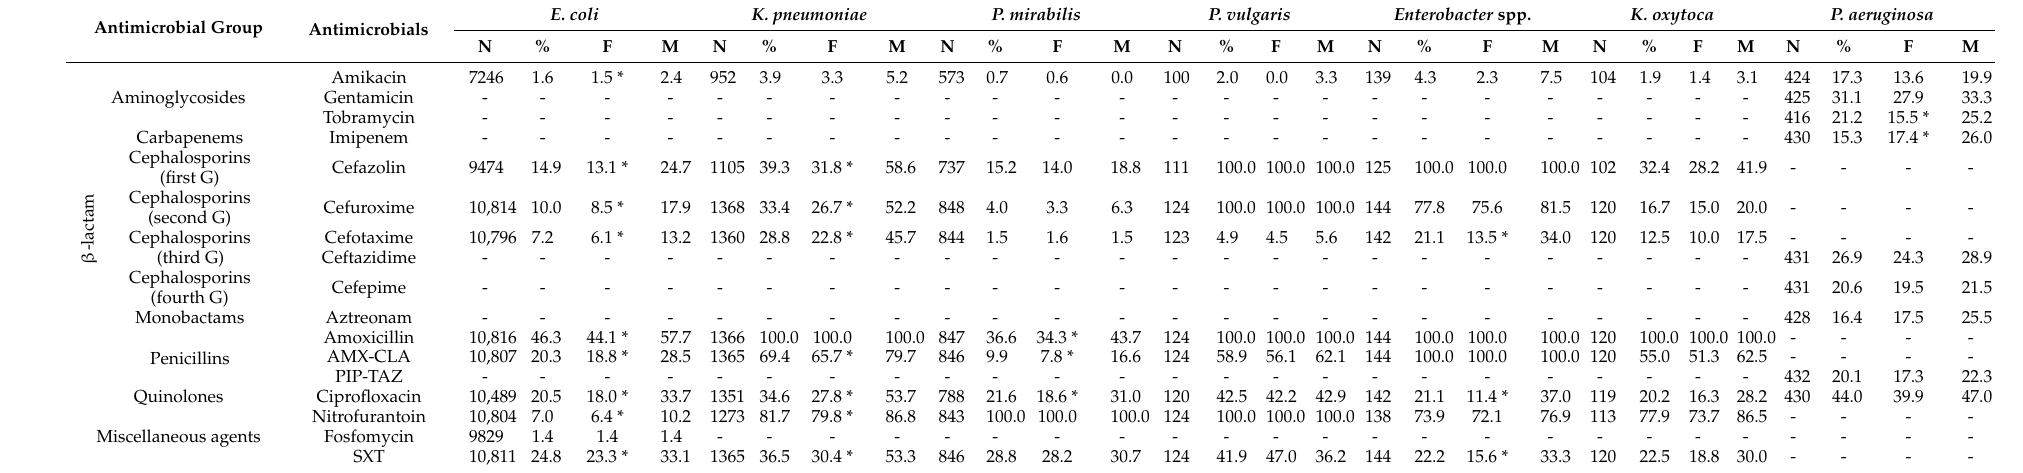
Table 2. Average antimicrobial resistance of the main Gram-negative uropathogens for female and male patients. Antimicrobial